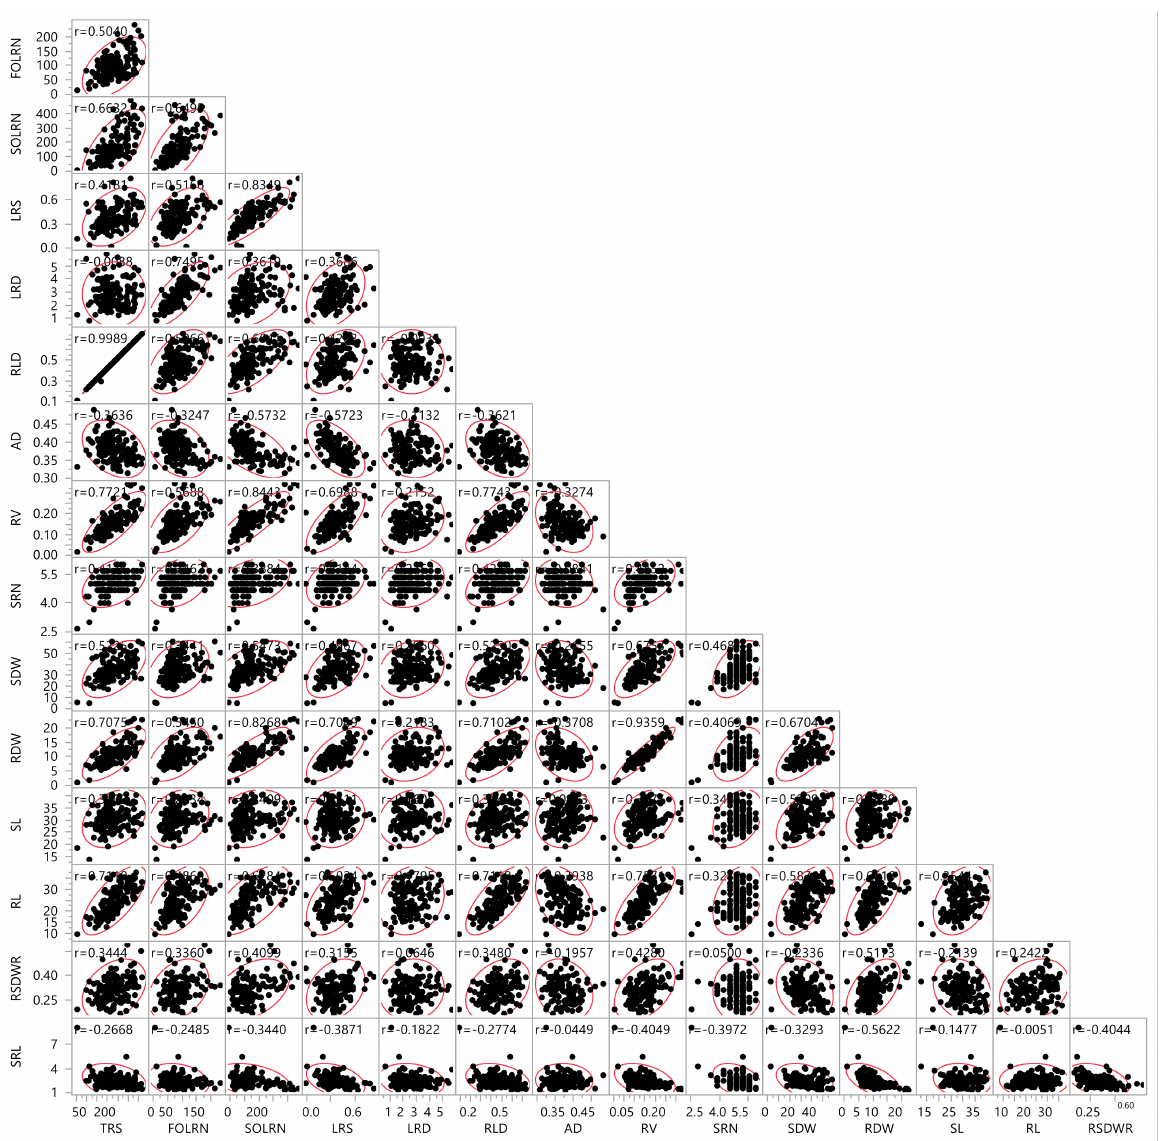
Figure 1. Correlations between root system architecture traits and shoot traits. TRS, total root size (cm); FOLRN, first order lateral root number; SOLRN, second order lateral root number; LRS, lateral root size; LRD, lateral root density (cm − 1 ); RLD, root length density cm − 2 ; AD, average diameter (mm); RV, root volume (cm 3 ); SRN, seminal root number; SDW, shoot dry weight (mg); RDW, root dry weight (mg); SL, shoot length (cm); RL, root length (cm); RSDWR, root shoot dry weight ratio; SRL, specific root length (cm mg − 1 ). Red boundary for each pairwise correlation displays density ellipses covering 95% points between each variable. The density ellipses are a graphical indicator of the correlation between two variables. It collapses diagonally as the correlation between the two variables approaches either 1 or − 1. It is more circular if the two variables are less